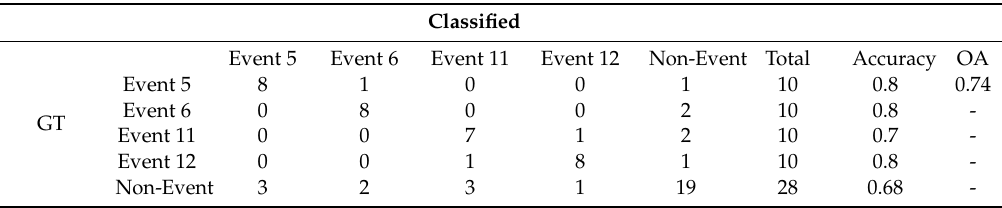
Table 3. Event classification performance using a rule-based approach for only 20 VIRAT videos. Confusion matrix and OA are